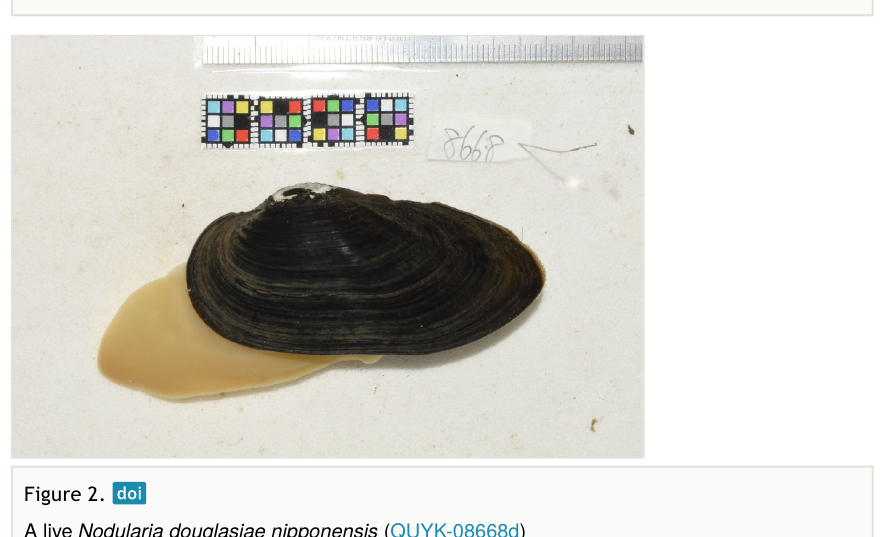
All specimens were CT scanned (Aloka Latheta LCT-200, Hitachi Ltd., Japan) and 3D surface models (Fig. 3; CT value: − 450 to 600) were extracted from the CT data (Figs 4, 5).